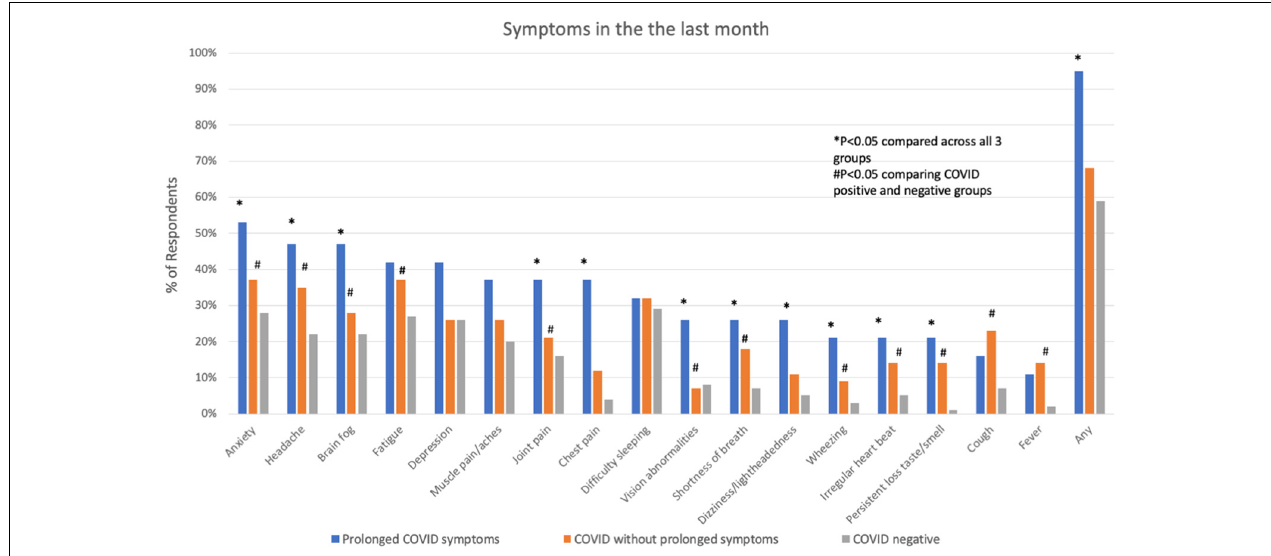
FIGURE 1 | Symptoms in the month prior to interview in subjects with prolonged COVID-19 symptoms, COVID-19 without prolonged symptoms and COVID-19 negative subjects. * P < 0.05 comparing across all three groups; # P < 0.05 comparing COVID positive to COVID negative.